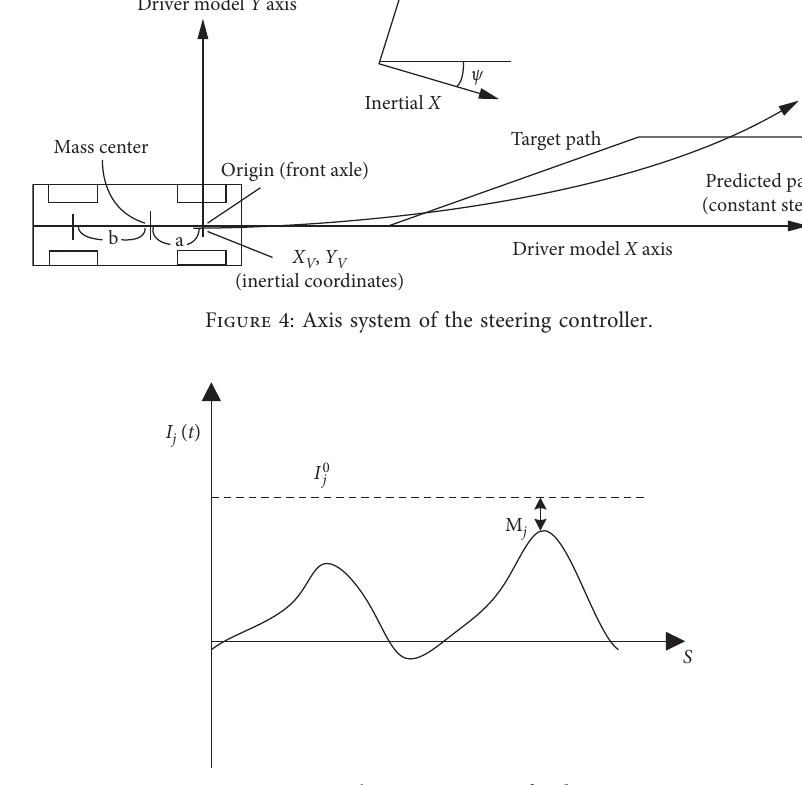
Figure 5: The station curve of index j.